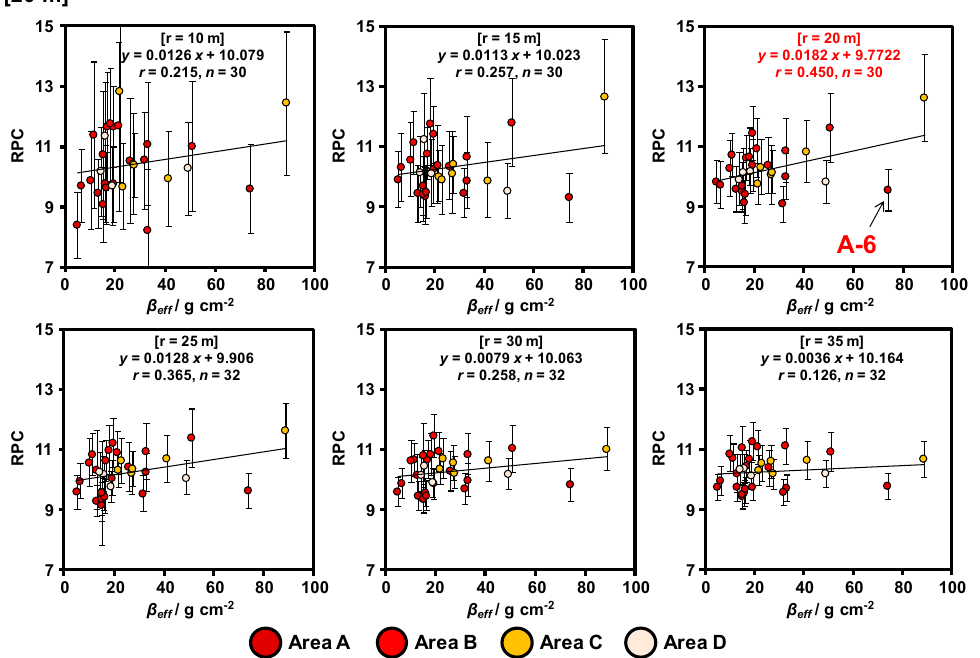
Figure 8. Relationship between RPC at 20 m agl. and β eff with different selected ranges based on soil sampling points.